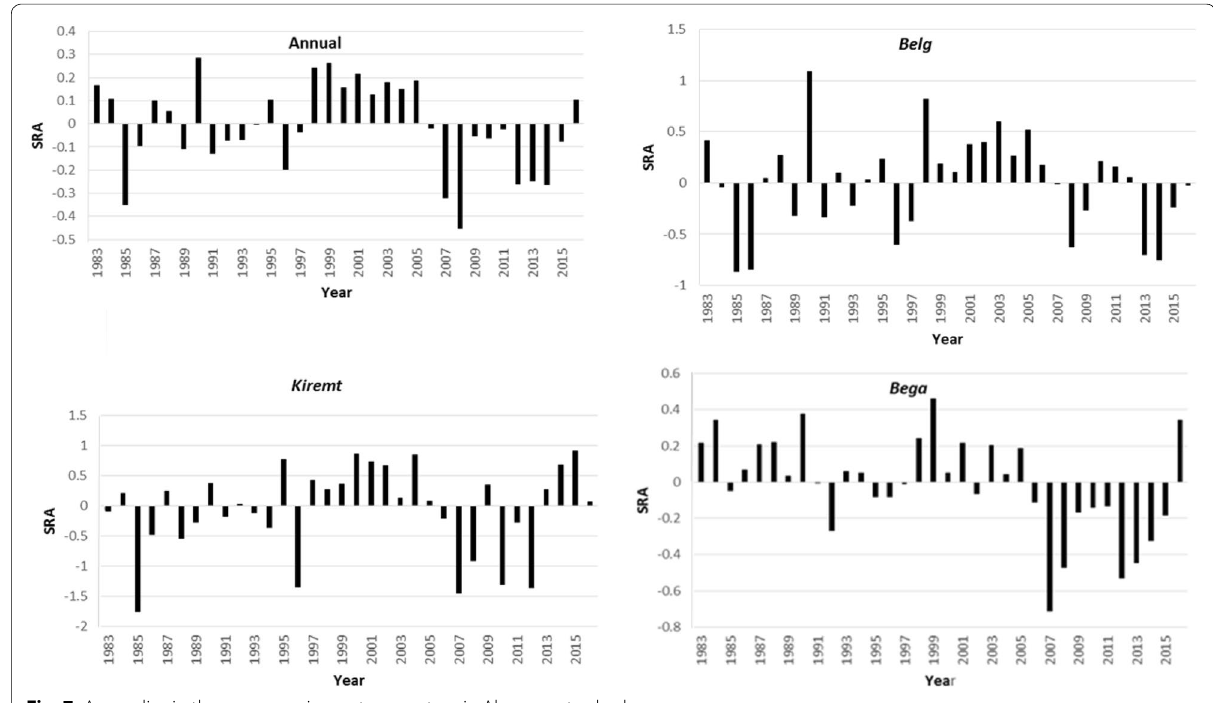
Fig. 7 Anomalies in the mean maximum temperature in Alwero watershed